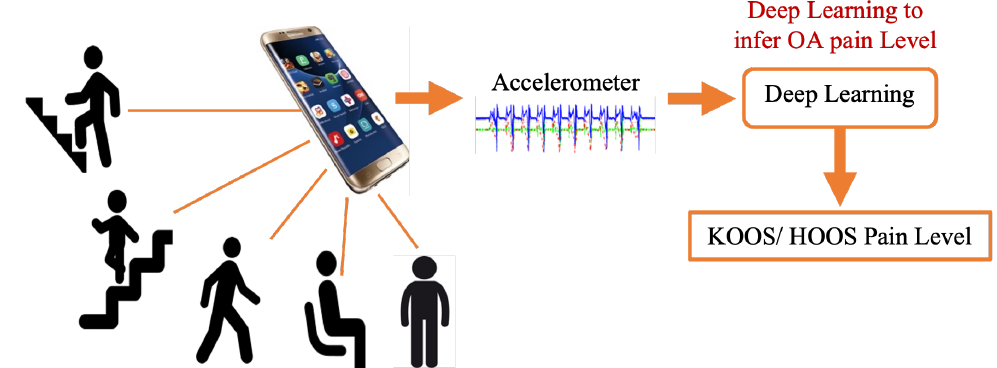
Figure 3. OA-Pain-Sense future application.